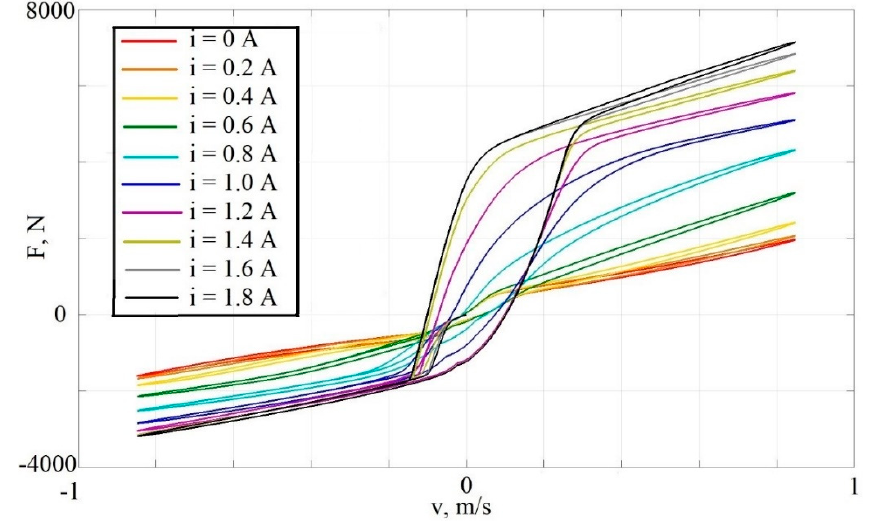
Figure 2. Active shock absorber dissipative characteristics set with different values of control currents i C , i R .